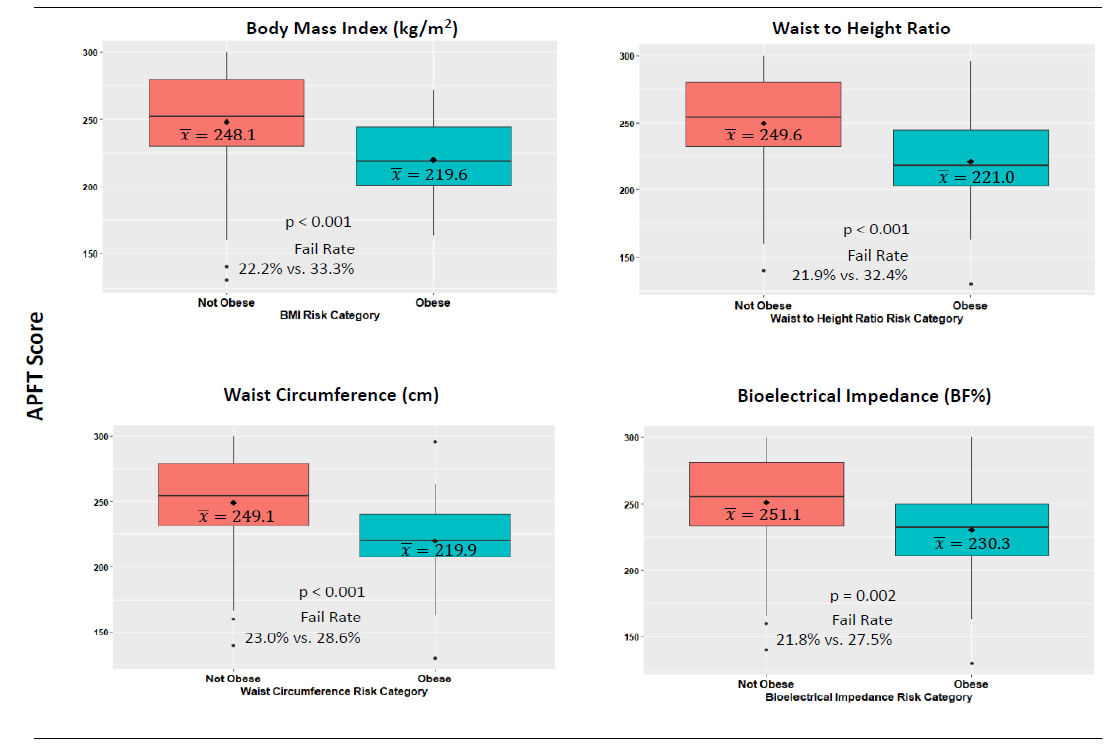
Figure 2. Body composition risk categories and performance on the army physical fitness test. Note: The diamond within each boxplot denotes the mean value.